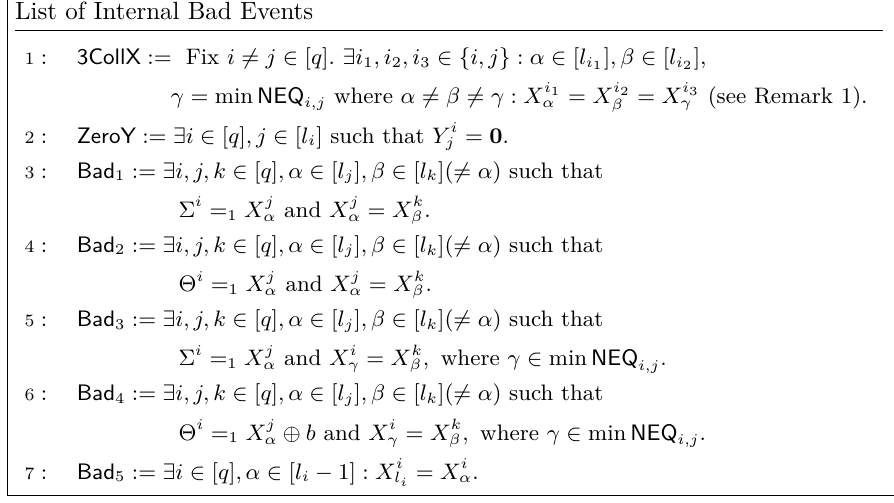
Figure 6.1: List of Internal Bad